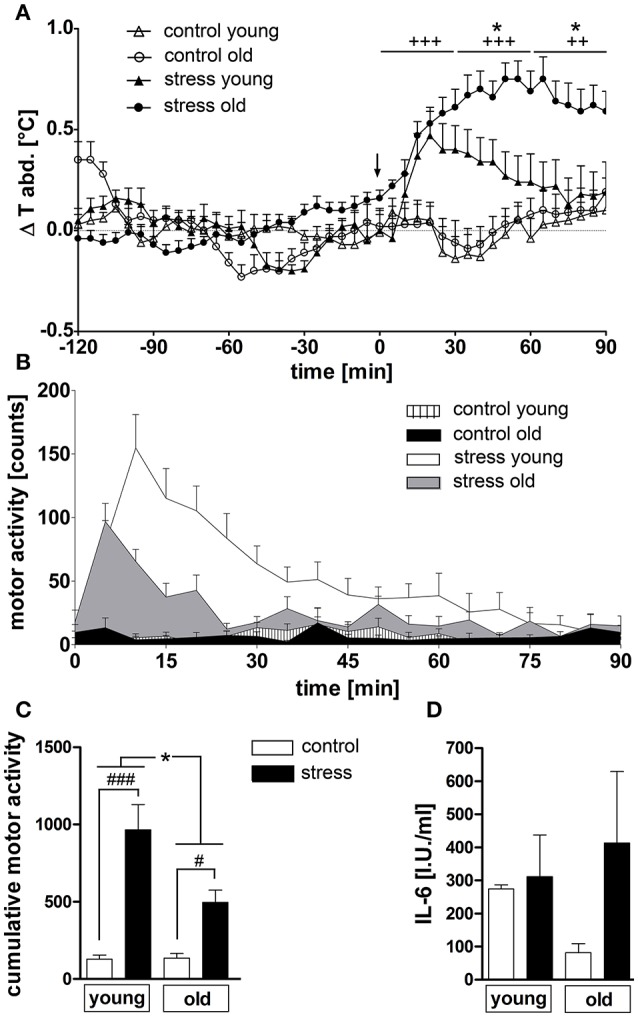
(A) Novel environment stress (beginning of stress indicated by a black arrow) over 90 min induced a rise in abdominal temperature in both age groups, which was strongly enhanced in old male rats compared to young male counterparts. (B,C) On the contrary, the stress-induced rise in motor activity, present in both age groups, was significantly higher in the young rats. (D) Plasma interleukin 6 (IL-6) levels were not affected by treatment or age. + main effect of treatment (not indicated for (C); * main effect of age; #post hoc stress different from control; #, *P < 0.05, ++ P < 0.01, +++, ###P < 0.001. Control young n = 12 (6 in D), stress young n = 12 (4 in D), control old n = 13 (12 in B,C, 5 in D), stress old n = 14 (13 in B,C, 5 in D).